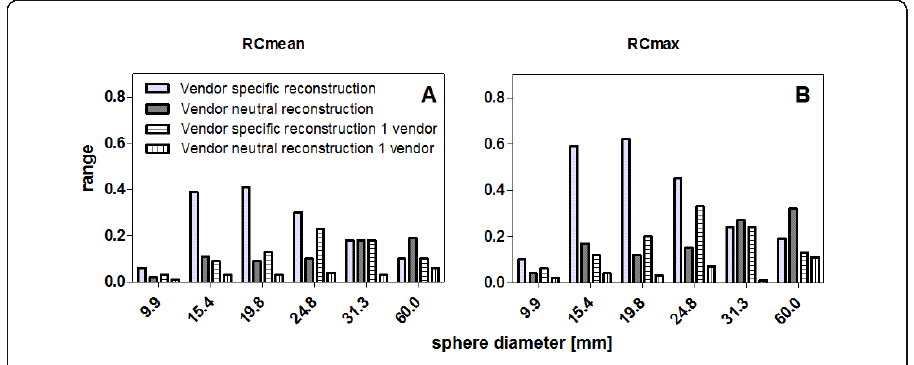
Fig. 6 Comparison in range over all systems in RC mean ( a ) and RC max ( b ) per sphere diameter for data reconstructed with a vendor-specific algorithm versus a vendor-neutral algorithm. Third and fourth